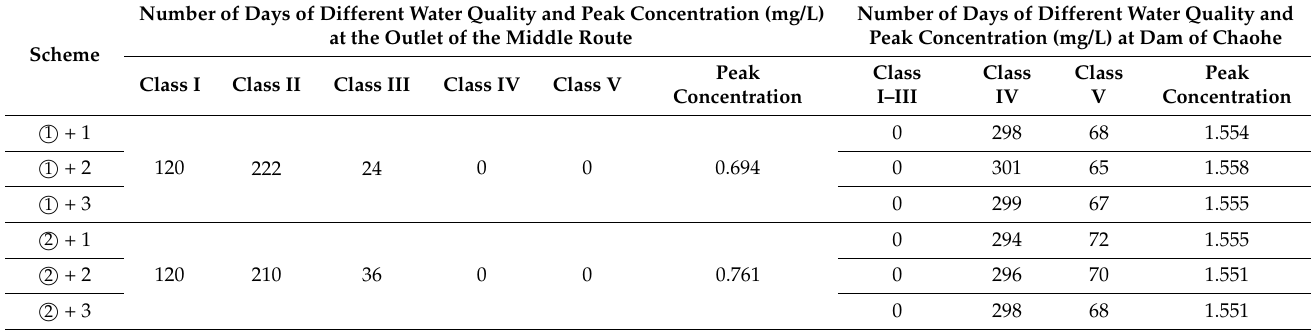
Table 3. Water quality results of different schemes in 2016 under atmospheric deposition.